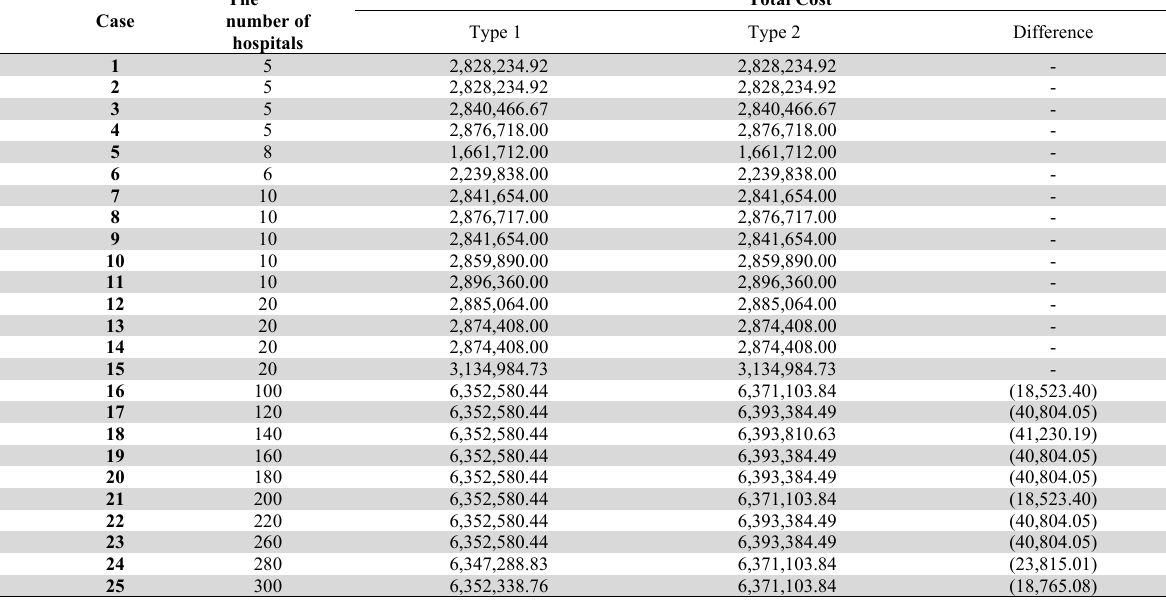
Result of comparisons total cost of dividing and not dividing the group of destroy